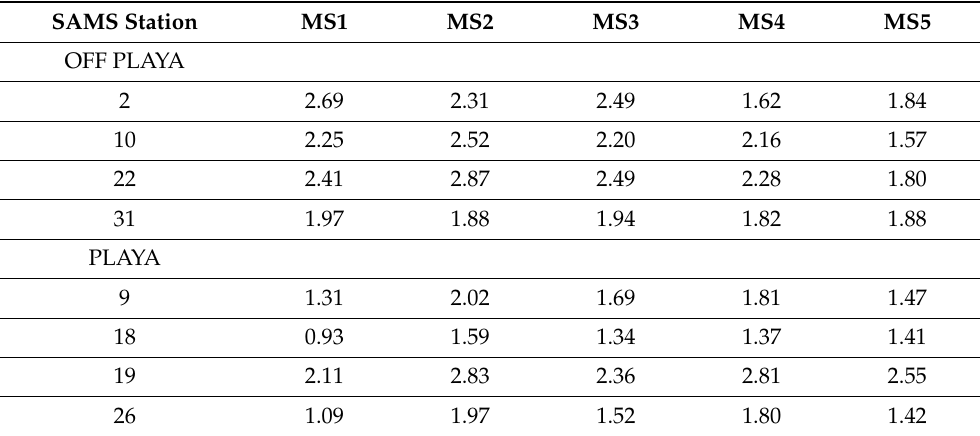
Table 3. Aggregate 2 m AGL temperature mean absolute error values for each model